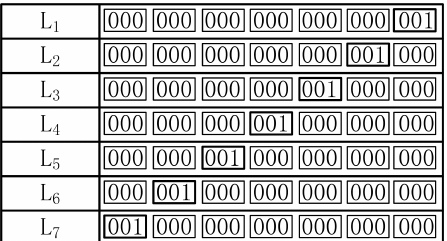
Figure 2. Service Category Table when L = 7.